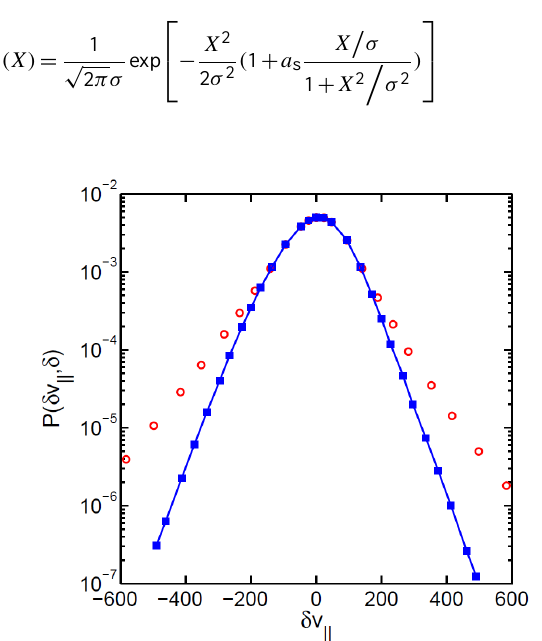
Fig. 9. P(δv || ,δ) at δ = 48 1 from ROMA and monofractal scal- ing relations. Blue curve with squares is based on multifractal ROMA spectrum s(Y ) shown in Fig. 5a; red circles are based on the monofractal scaling with s =0.4. Both use the scaled PDF P s (Y) given in Fig. 5b. There are little differences between the two for | δv || | < 200. However, at larger | δv || | , the value from the ROMA scaling is smaller than the value from the monofractal scal- ing. For instance, at δv || = 400, the value based on the ROMA scaling, which agrees with the data as shown in Fig. 6a, is smaller than the value based on the monofractal scaling by a factor of 15.